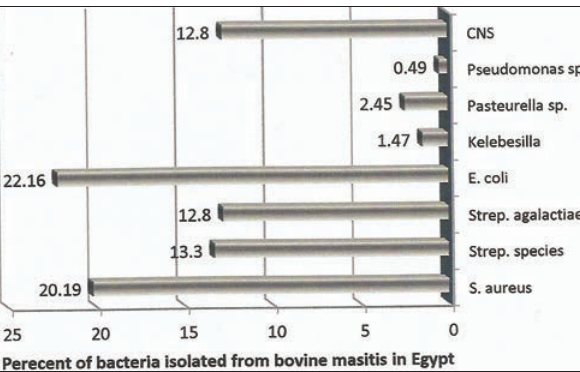
Figure-2: Percentage of isolated bacteria from bovine mastitis in